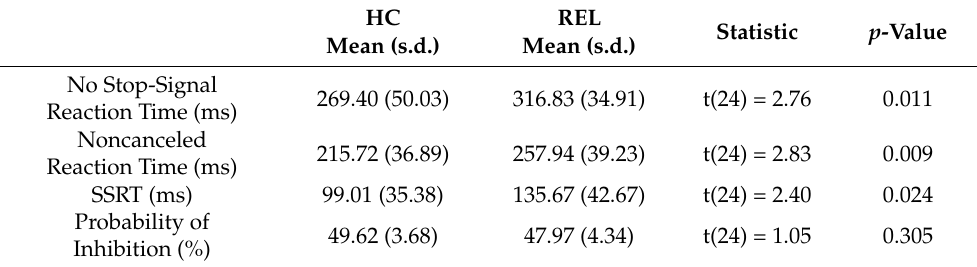
Table 3. Stop-signal task performance for healthy controls and relatives.